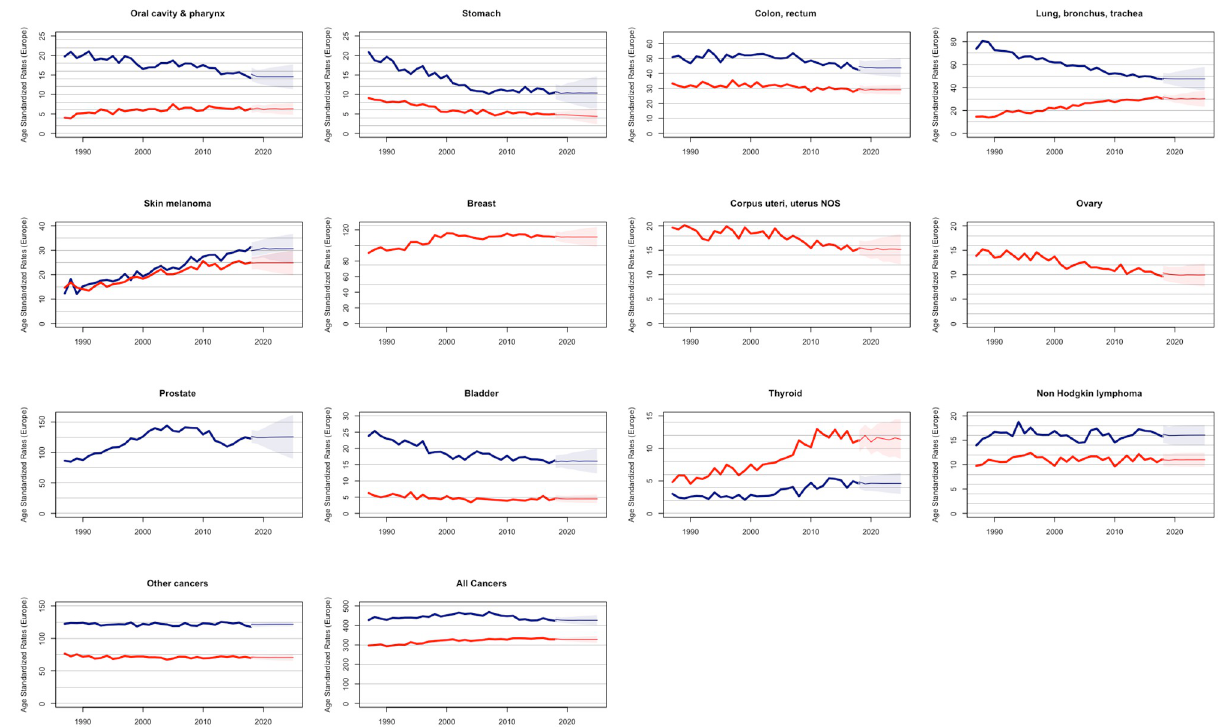
Fig 1. Observed and projected age standardized rates for all cancers and 12 cancer sites in Switzerland. Bold lines represent actual rates; thinner lines represent projected rates; shaded areas represent 95% prediction intervals. Men in blue; women in red.